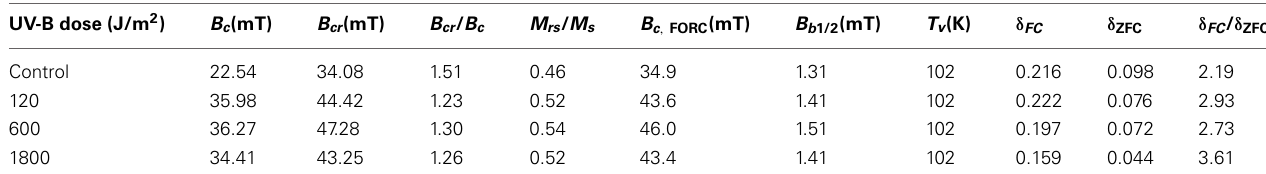
Table 2 | Magnetic parameters of the bulk AMB-1 samples at different irradiation levels. UV-B dose (J/m 2 )